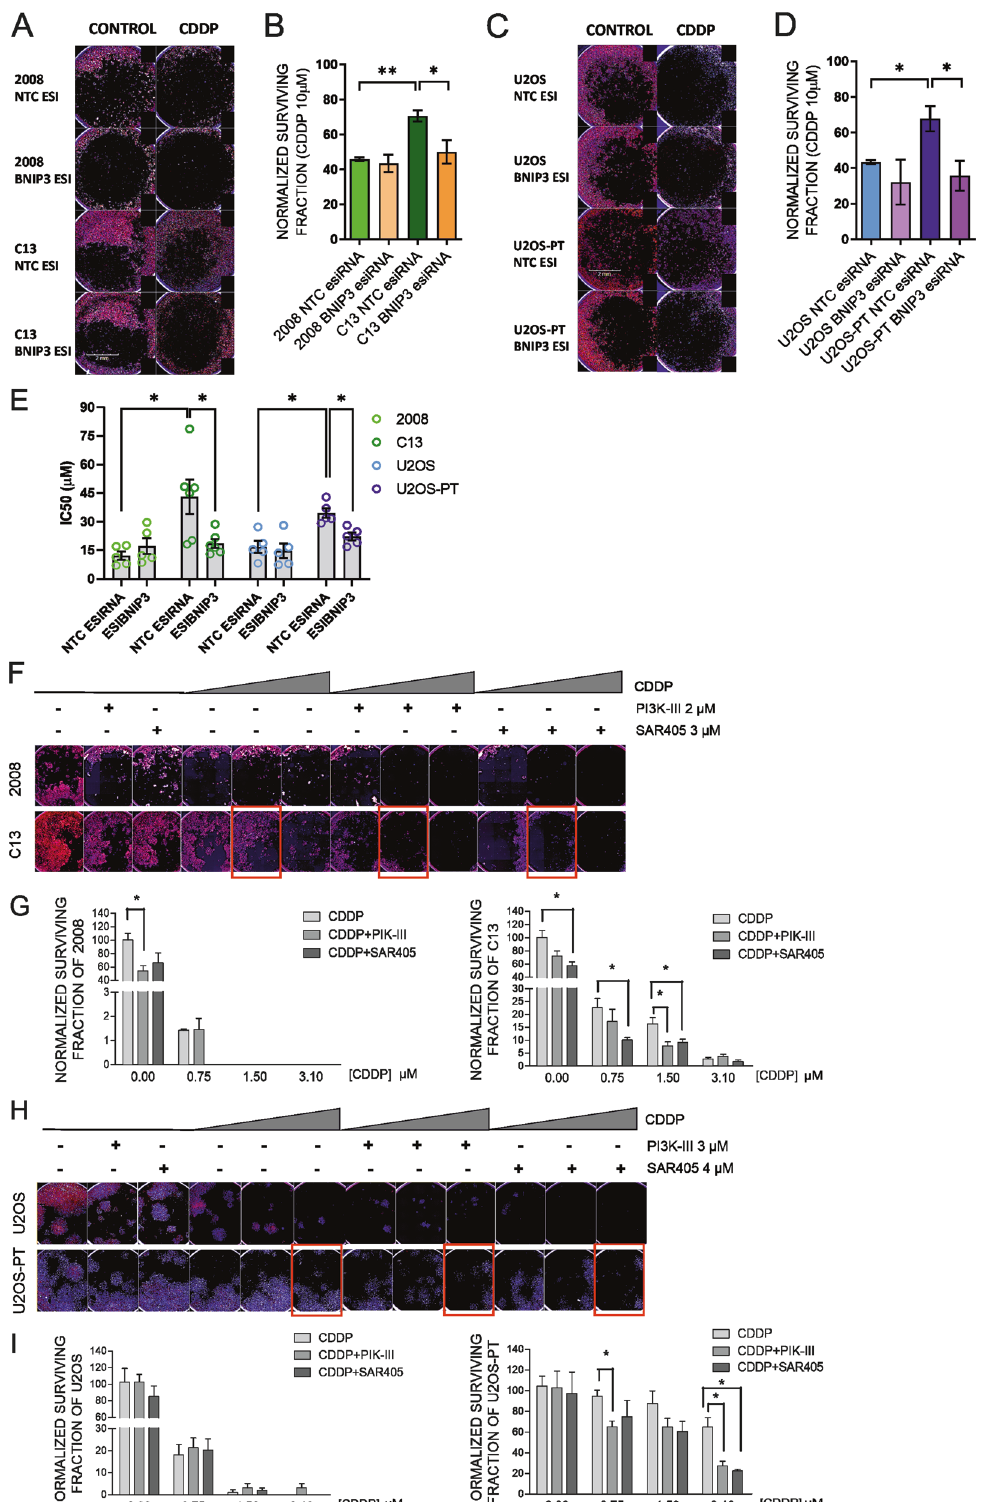
Confocal Microscope (LSM700 microscope). Images were acquired with 63X objective for osteosarcoma cells and 100X for ovarian cancer cells and 15 planes were acquired in z-stack with a distance of 0.4 μ m between each plane for each cell. The following fi lter was utilized: 488 (Ex. 490 – 510 / Em. 520 – 560). After